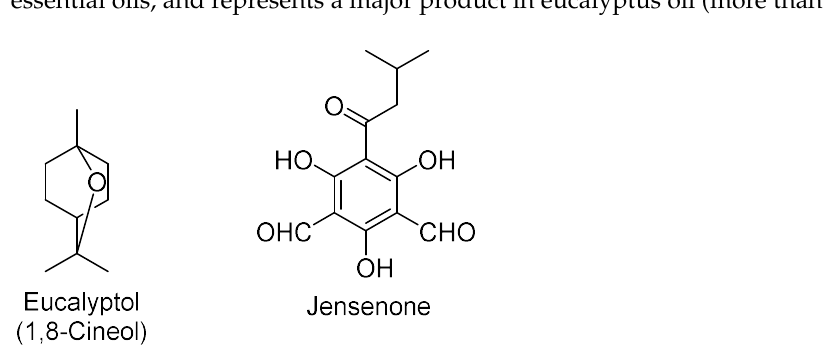
Figure 2. Structures of the organo-sulfur compounds, the active components of garlic oil.